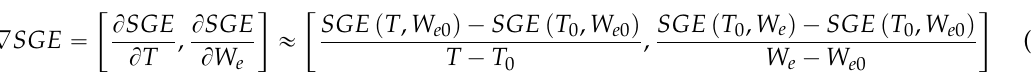
opposite side of the stripe; and ( c ) The two groups of fitted lines on both sides of the stripes.